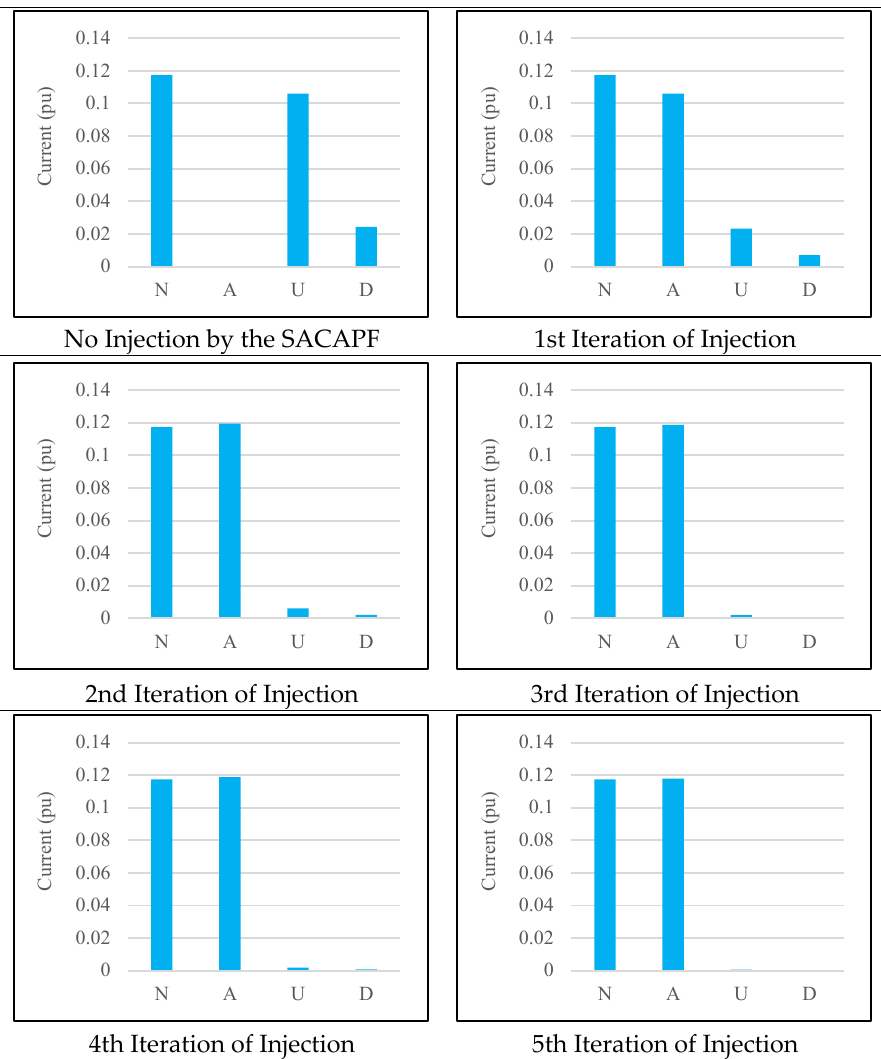
Figure 8. The RMS value of harmonic content of nonlinear load (N), SACAPF current (A), harmonic content of upstream branch (U), and harmonic content of downstream branch (D) in 5 iterations of SACAPF operation .